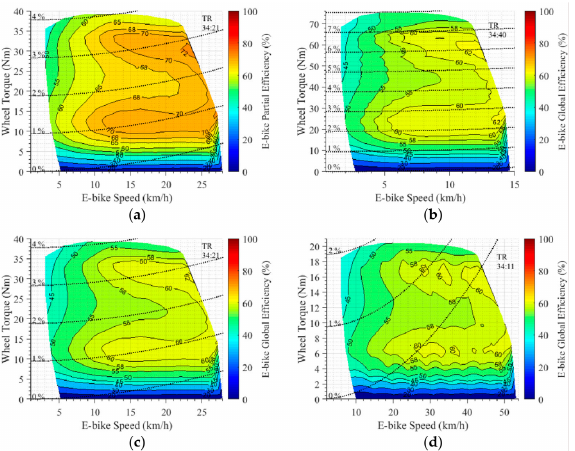
Figure 7. ( a ) E-bike partial efficiency map with 34:21 transmission ratio (TR). ( b ) E-bike global efficiency map with 34:40 TR. ( c ) E-bike global efficiency map with 34:21 TR. ( d ) E-bike global efficiency map with 34:11 TR.